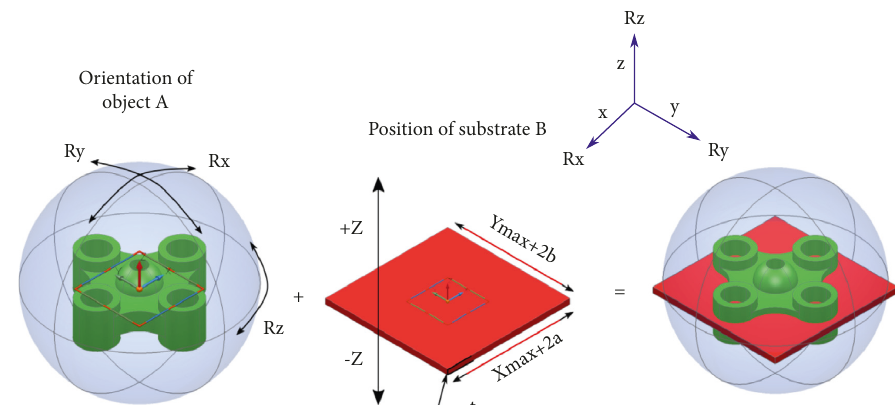
Figure 6: Orientation of the object and position of the substrate.